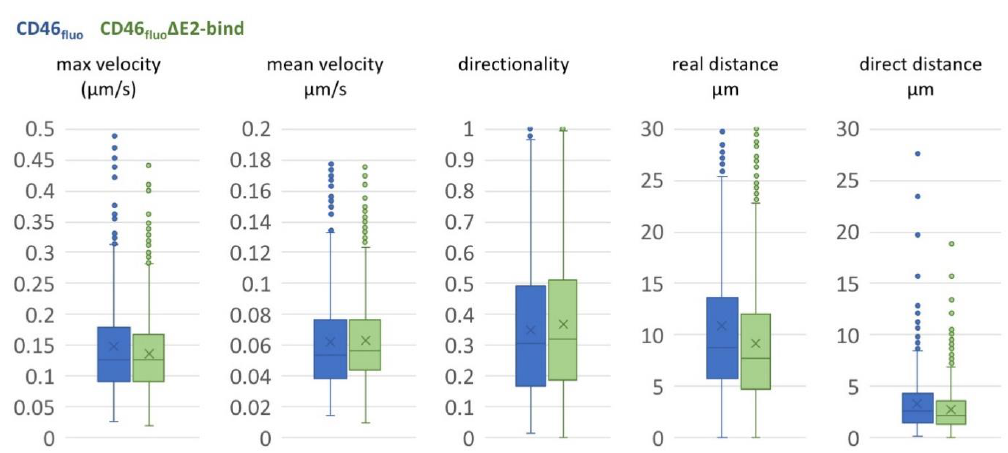
Figure 4. Movements of BVDV E2-mCherry on the surface of SK6 CD46 fluo (blue) or CD46 fluo ∆E2bind cells (green) are comparable. Box and Whisker blots of maximum and mean velocity, directionality, real distance and direct distance of particles tracked on the surface of SK6 CD46 fluo (blue, n = 801) or CD46 fluo ∆E2bind cells (green, n = 1081), respectively. The mean is indicated by x and outliers (Q3 + 1.5-times interquartile range) are indicated by dots.